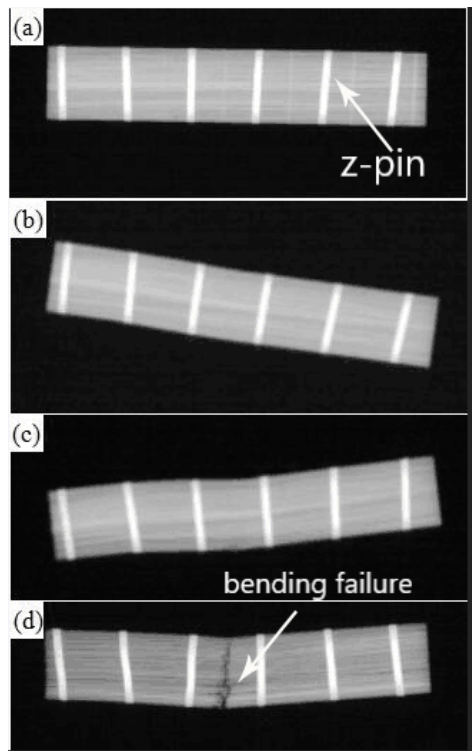
Figure 11. X-ray images of z-pinned composite with a z-pin volume content of 1% and 0.6 mm diameter ( a ) before testing ( b ) at maximum shear stress ( c ) when load-bearing capacity dropped to 50% ( d ) after fracture.